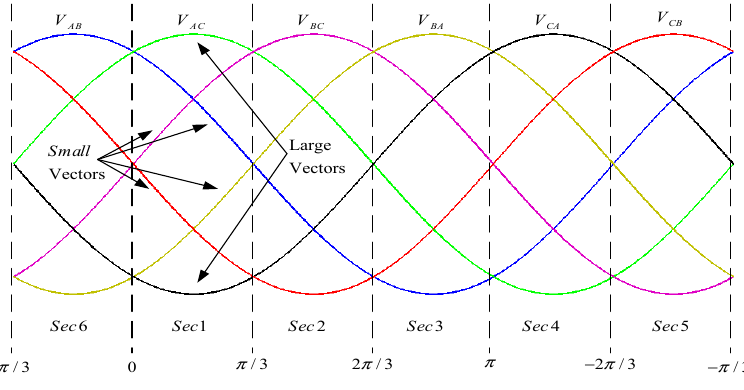
Figure 5. Input voltage vector direction starting from 0 rad .